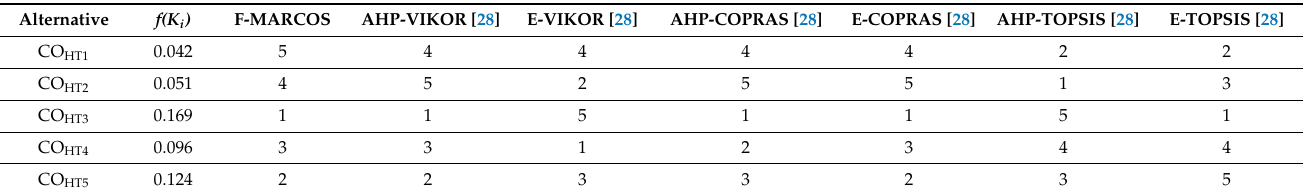
Table 14. Final ranking of the